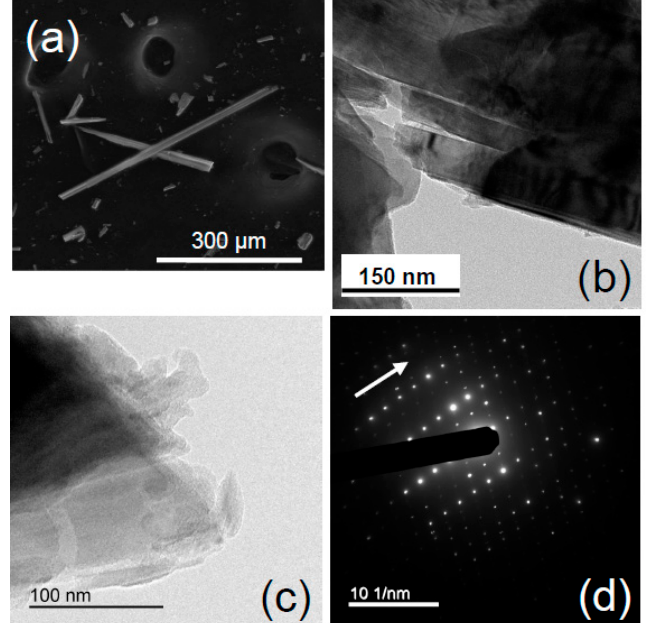
Figure 7. ( a ) Representative FEG-ESEM images of the typical appearance of tremolite from Val d’Ala, Turin (Italy) (Table 1). ( b ) TEM medium high-resolution images displaying cleavage fragments that were detaching from the main fibre, with disoriented Moiré fringes. ( c ) HRTEM image showing highly irregular edge features. ( d ) Representative SAED pattern oriented parallel to the c* axis.